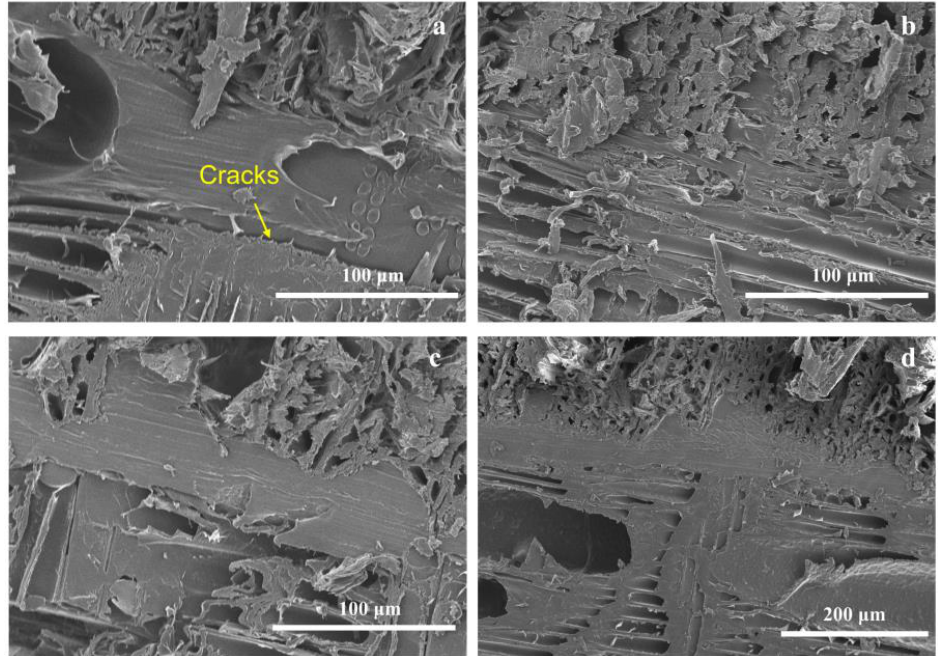
Figure 5. SEM micrograph of the interface between the veneer and: ( a ) LDPE; ( b ) LDPE with KH550 as the coupling agent; ( c ) PVC; ( d ) PVC with KH550 as the coupling agent.